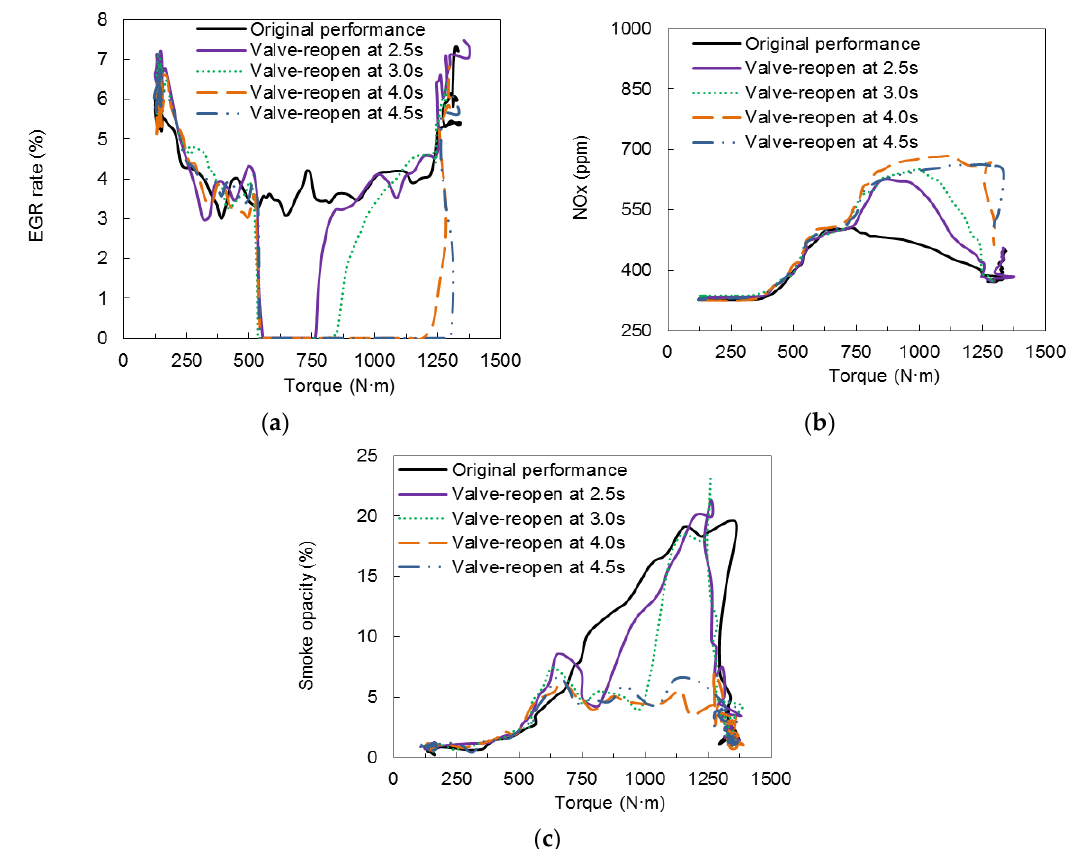
Figure 6. Effect of different EGR valve-reopen time on diesel emission performance: (a) EGR rate ； ( b ) NOx; ( c ) Smoke opacity.